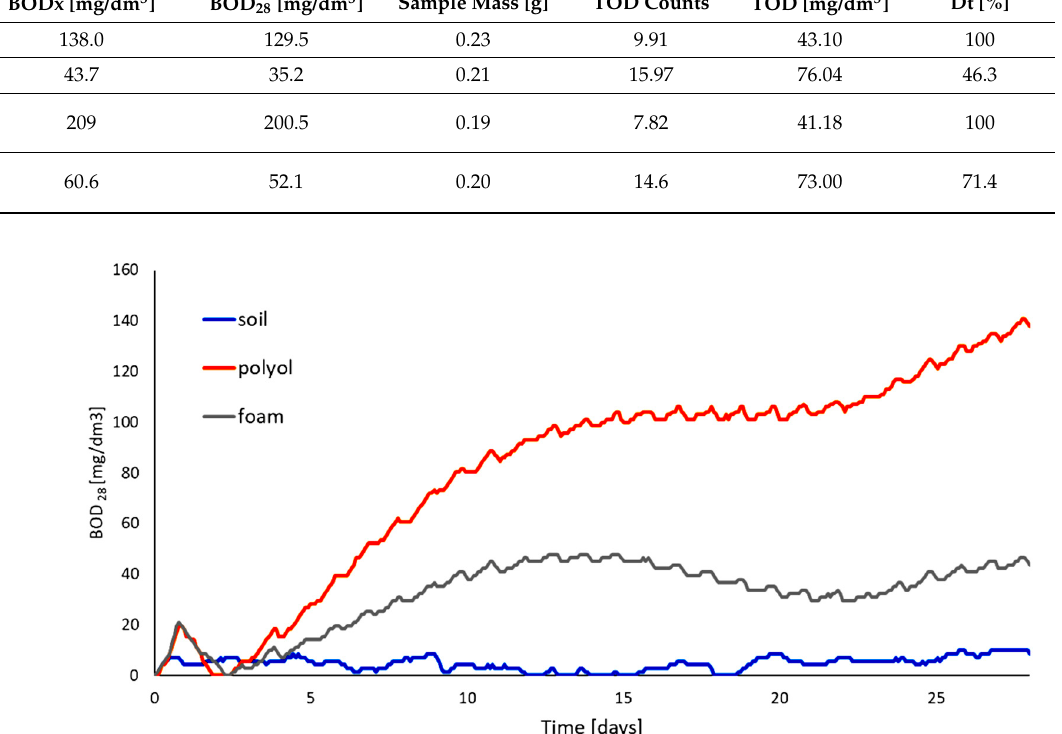
Figure 9. Results of biochemical oxygen demand of polyol and foam. Table 11. Mass shares of individual elements in polyol and foam.